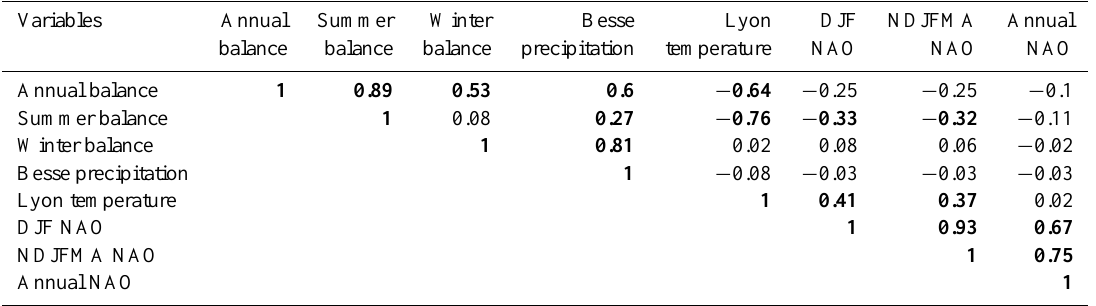
Table 2. Correlation matrix between the different time series. Bold face values are significant non-zero correlations at the 95% confidence level. Besse precipitations are winter cumulative precipitations between Sarennes field visits. Lyon temperatures are May–October daily means.